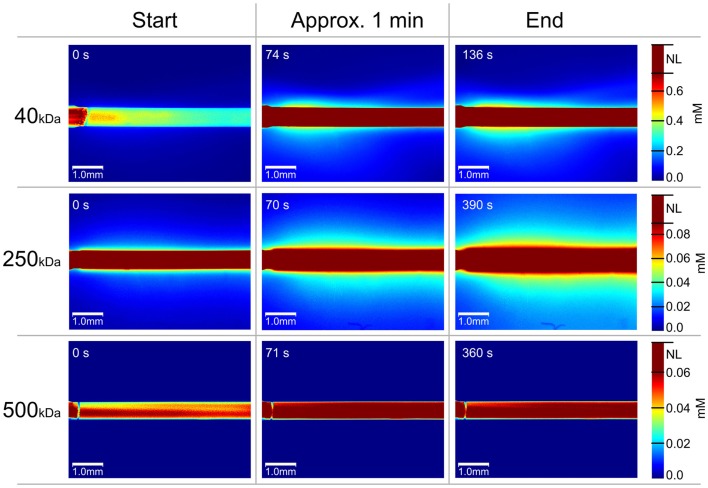
Temporal evolution of MD catheter dextran leakage pattern is shown. All images are color coded according to the pixel color-dextran molecular concentration linearity, to reveal quantitative information on the dextran leakage. The scale bars on the right show the dextran molar concentration (millimolar) depending on the pixel color. The pixels, which have color over the linear zone are all marked as non-linear (“NL”), which is displayed in dark red. Hundred kilodaltons of MWCO membranes are used (100 kDa Brain Microdialysis Catheter, M Dialysis AB). For Dextran 40 (kDa), three image timings are: 0 s, 1 min 14 s, 2 min 18 s; for Dextran 250 (kDa), the image timings are: 0 s, 1 min 10 s, 6 min 30 s; and for Dextran 500 (kDa), the image timings are: 0 s, 1 min 11 s, 6 min. Reprinted with permission from Chu (46). Copyright 2014 Springer Science Media.